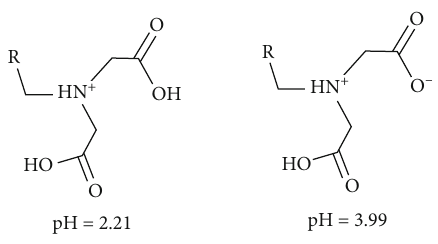
Figure 3: Structure of the iminodiacetic acid functional group at pH less than 2 and pH 3.99.